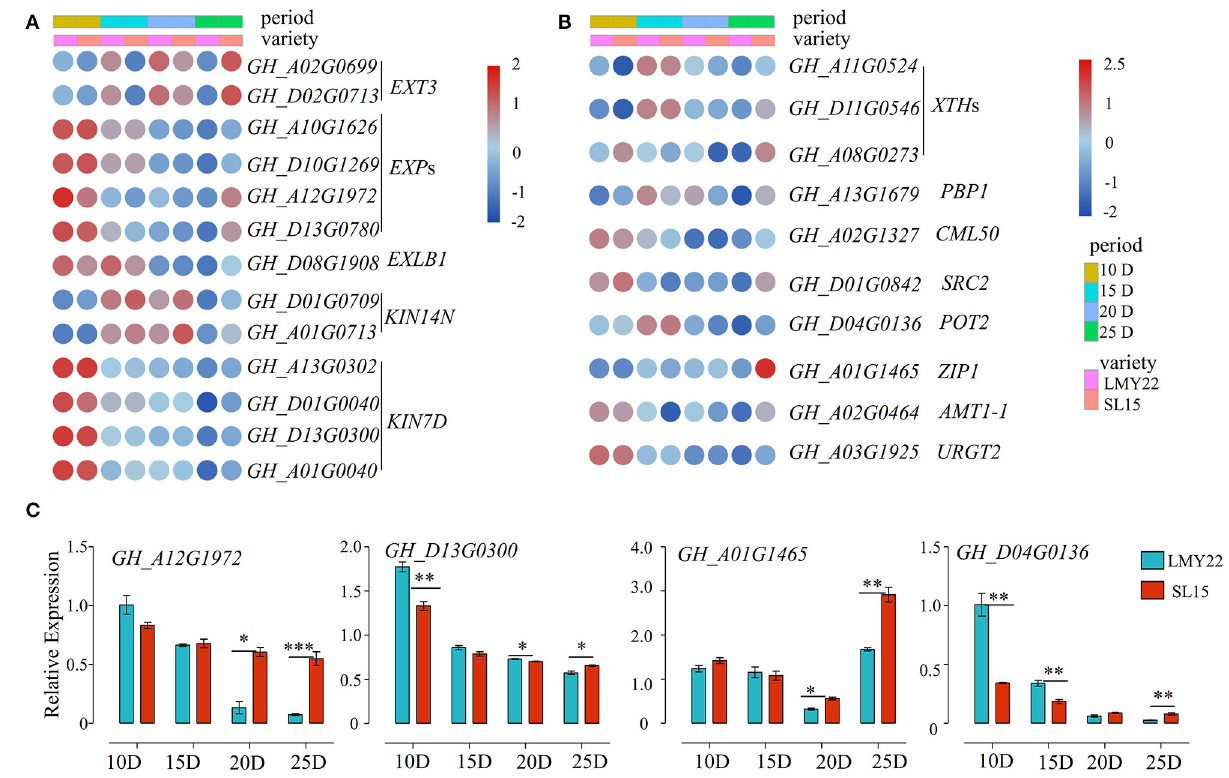
were randomly selected and confirmed by qRT-PCR ( Figure 4C